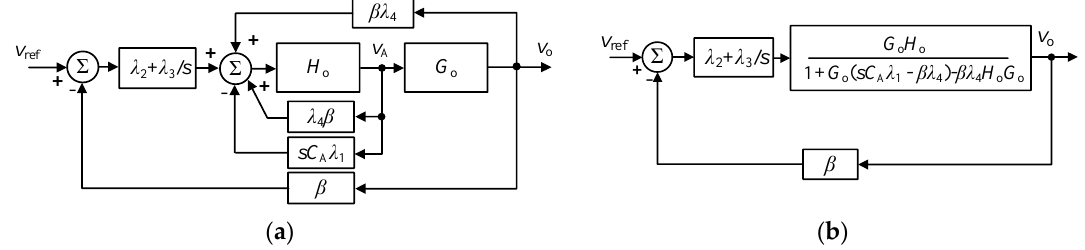
Figure 7. Closed-loop schematic of the class-D amplifier: ( a ) multi-loop form ( b ) reduced form.